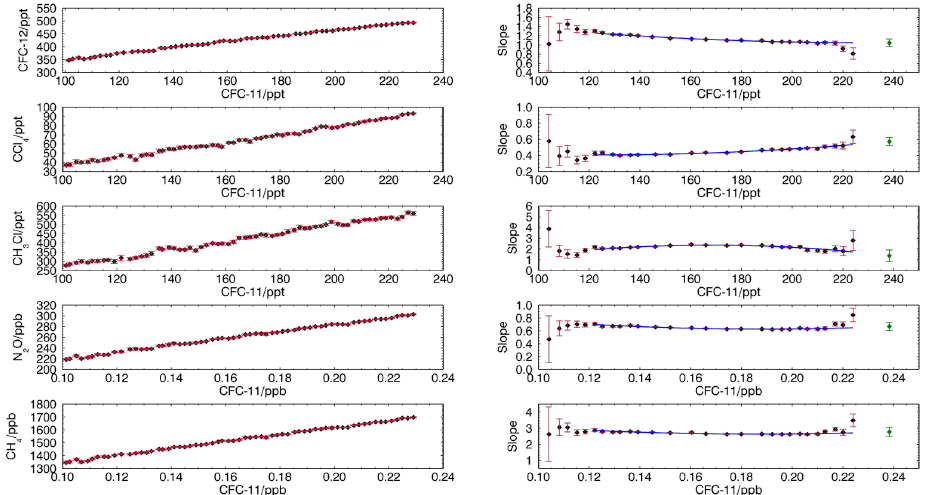
Figure B18 Correlations between the volume mixing ratios of CFC-12, CCl 4 , CH 4 , CH 3 Cl and N 2 O and CFC-11 for the data from the southern hemisphere during the stratospheric winter of 2007. Left panels: The mean correlation profile. Each point represents the mean of the VMR in a window of 2 ppt of CFC- 11. The error on these points is the standard deviation of the data within each 2 ppt window. Right panels: The local slope of data in an 80 ppt of CFC-11 window. The error on the points is the fitting error of this fit. The blue line is a second degree polynomial fit to the local slopes. The green point is the extrapolated slope at the tropopause.